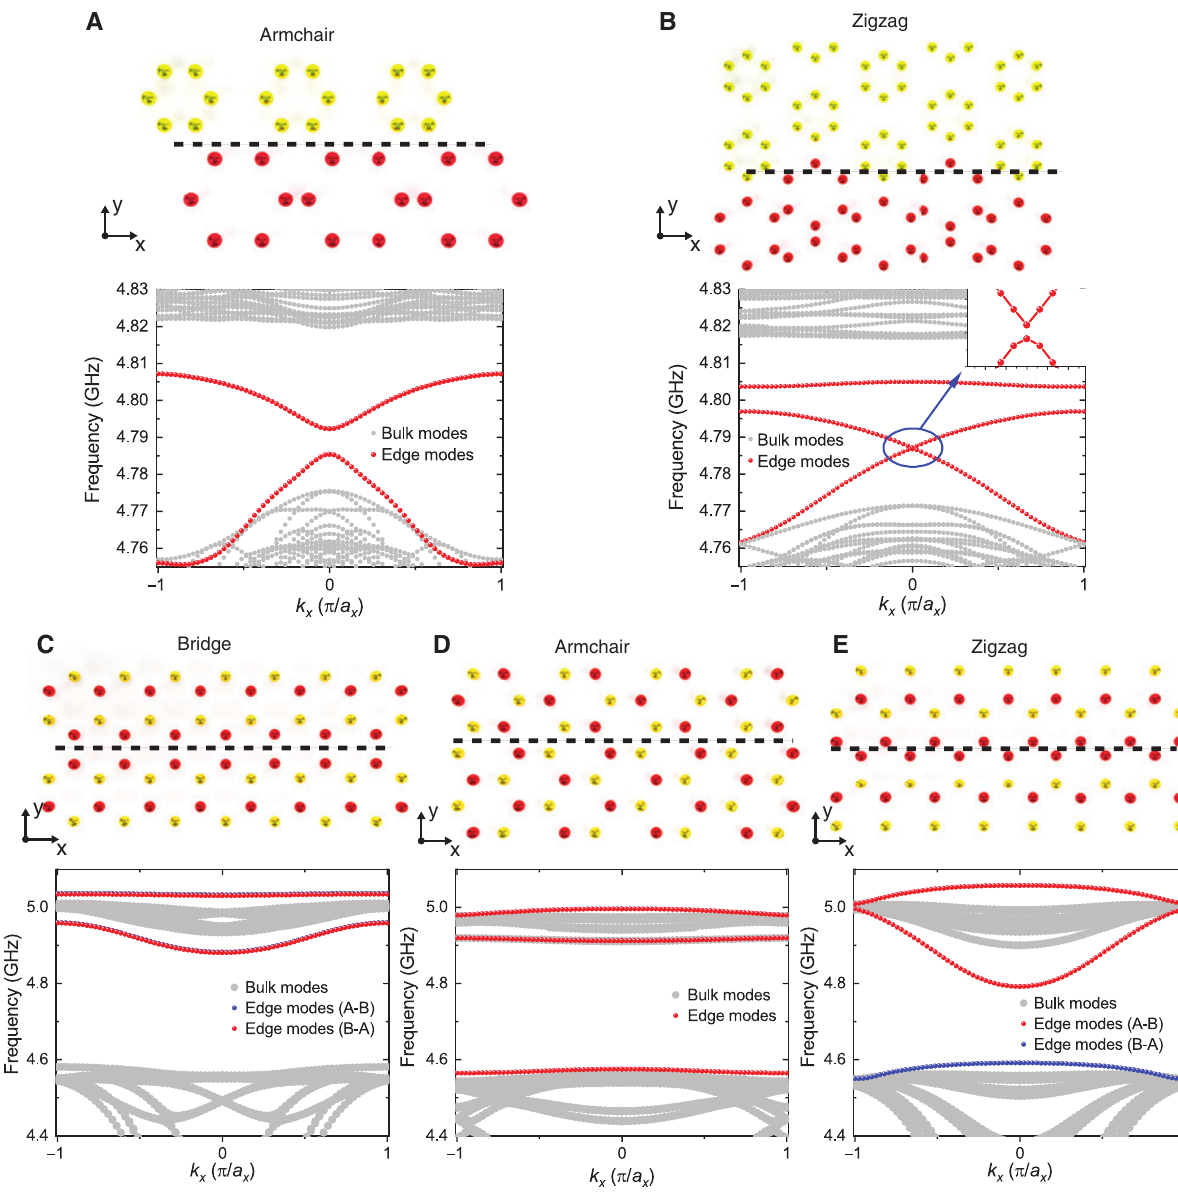
Figure 2: Possible interfaces and associated edge mode dispersions between C6-based and VH-based metamaterial TIs. (A) Armchair and (B) zigzag interfaces for the C6-based edge modes, (C) bridge, (D) armchair and (E) zigzag interfaces for VH-based edge modes. The bulk modes are shown in grey, and the edge modes in blue and red, depending on the sign of β